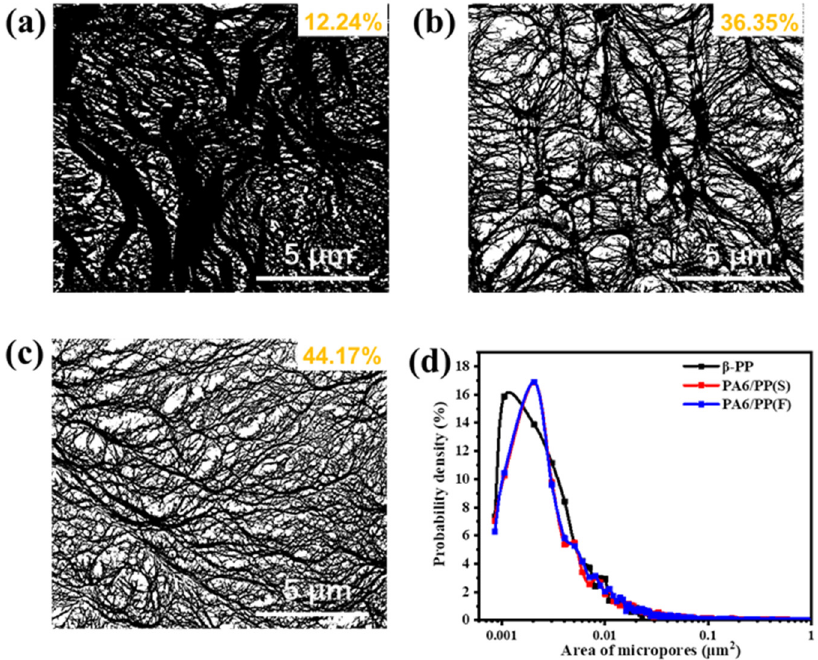
Figure 13. Microporous morphologies of ( a ) β -PP, ( b ) PA6/PP(S), and ( c ) PA6/PP(F) membranes processed using Image J software (the white part is the micropores and the black part is the PP matrix). The calculated surface porosity is indicated in the upper right corner of images. ( d ) The surface pore area distribution of the three microporous membranes.